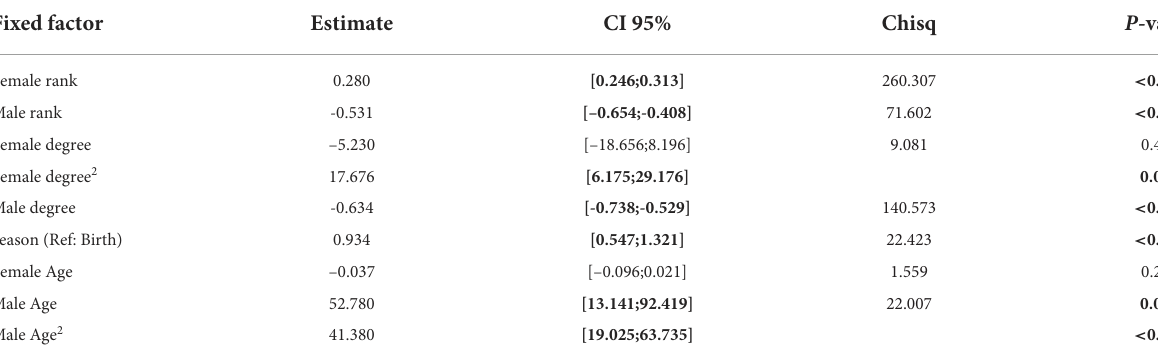
TABLE 1 Factors affecting the probability for a female to outrank a male (Number of observations: 5,433